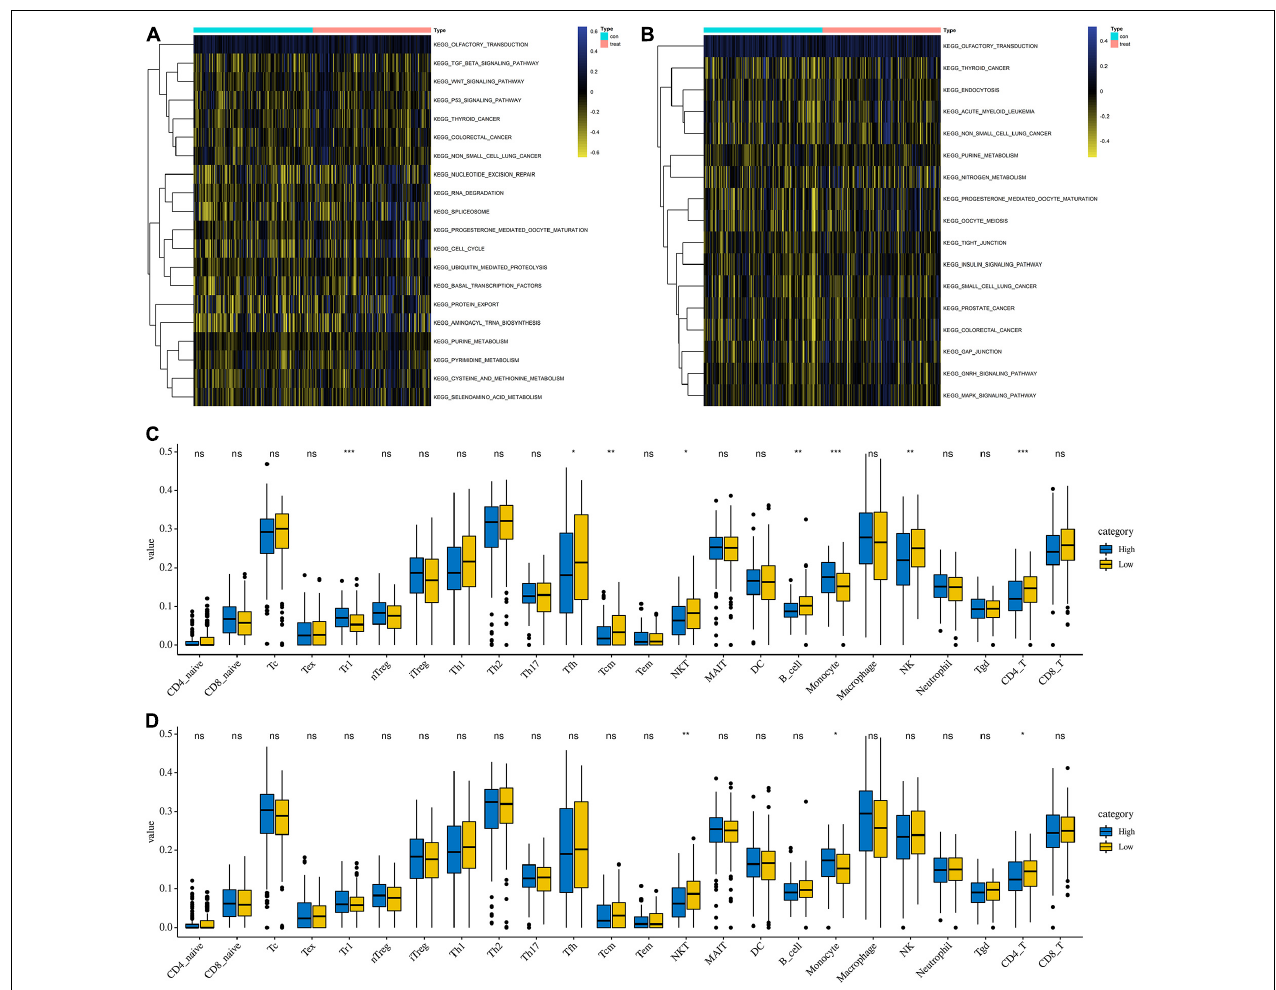
FIGURE 5 | GSVA analysis and immune feature between low- and high-risk groups. (A) GSVA analysis between low- and high-risk groups based on overall survival signature. (B) GSVA analysis between low- and high-risk groups based on progress free-survival survival signature. (C) Comparison of immune cell infiltration between low- and high-risk groups based on overall survival signature. (D) Comparison of immune cell infiltration between low- and high-risk groups based on progress free-survival